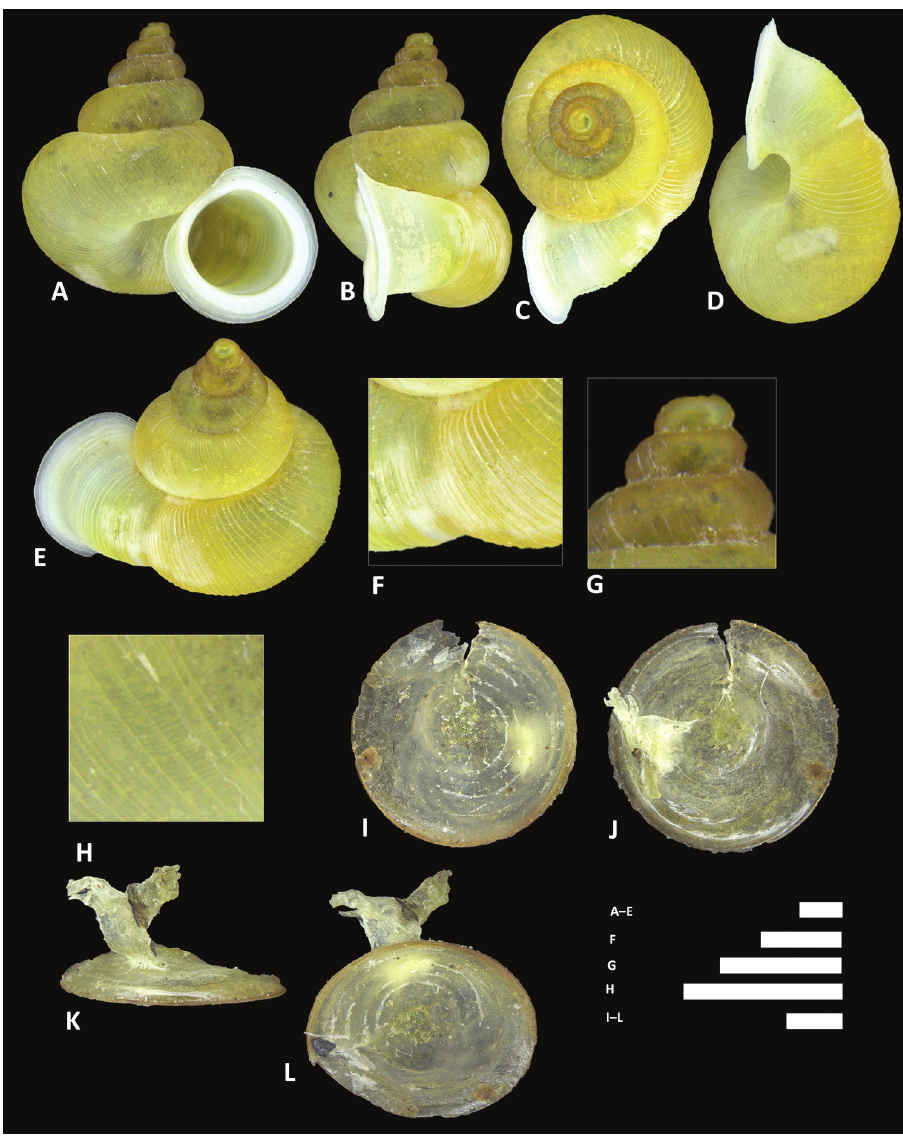
Figure 25. Alycaeus regalis , sp. n. A–E Shell of holotype, BOR/MOL 12990 F–H Close up of shell of holotype, BOR/MOL 12990 I–L Operculum of paratype, BOR/MOL 6881. Note operculum with proteinaceous interior extension. Scale bars: A–E, F, G, H 1 mm; I–L 0.5 mm. All photographs by Junn Kitt